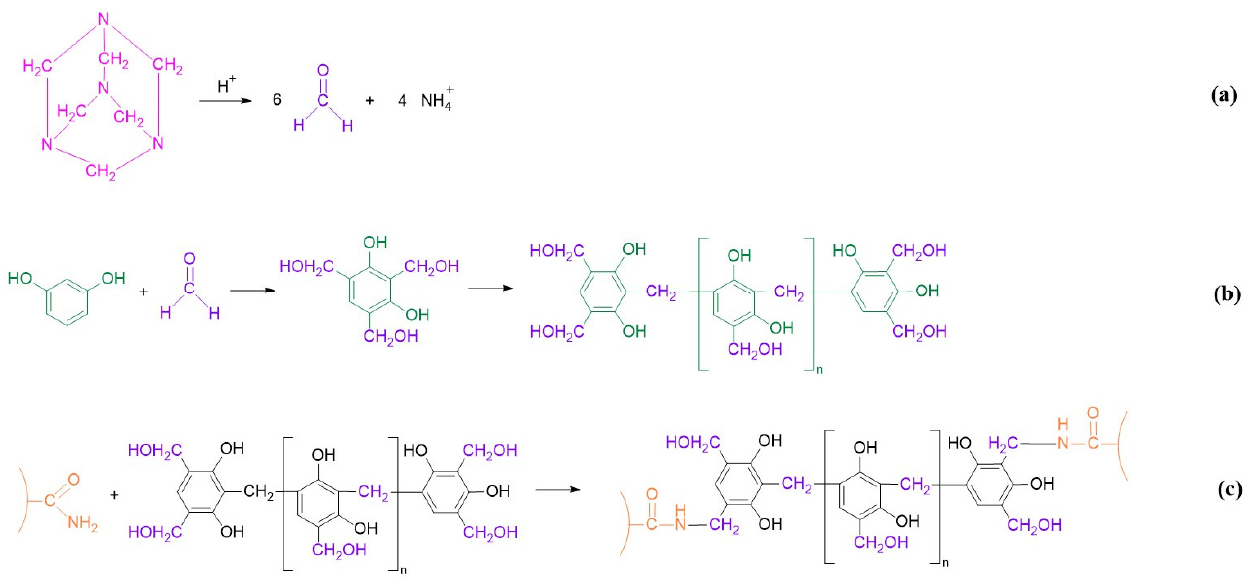
Figure 1. Reaction process of resorcinol /HMTA-based polymer gel. ( a ) Decomposition of HMTA into formaldehyde; ( b ) the generation of oligomers of phenolic resin; ( c ) cross-linking process between the phenolic resin and the HPAM.